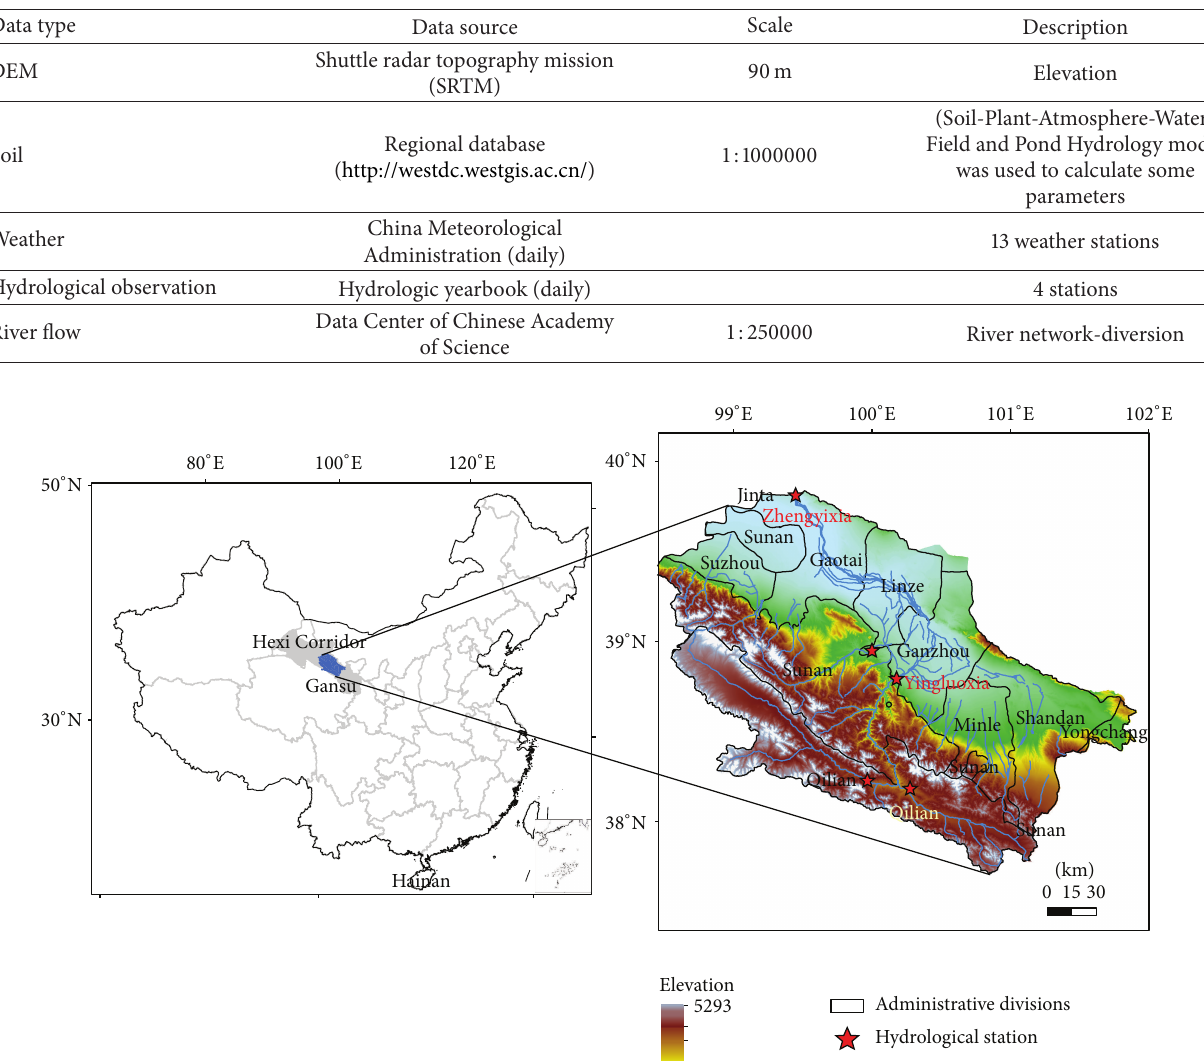
Table 1: Data used and sources information.